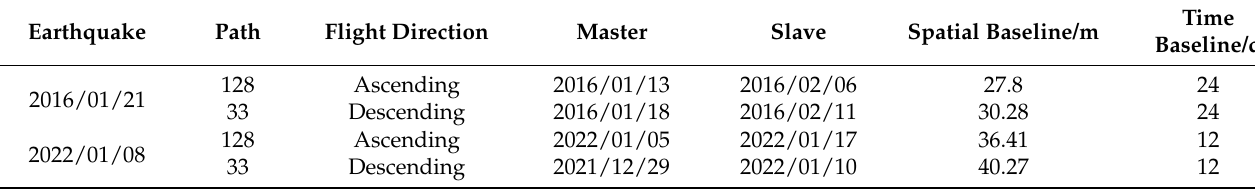
Table 1. Sentinel-1 SAR image